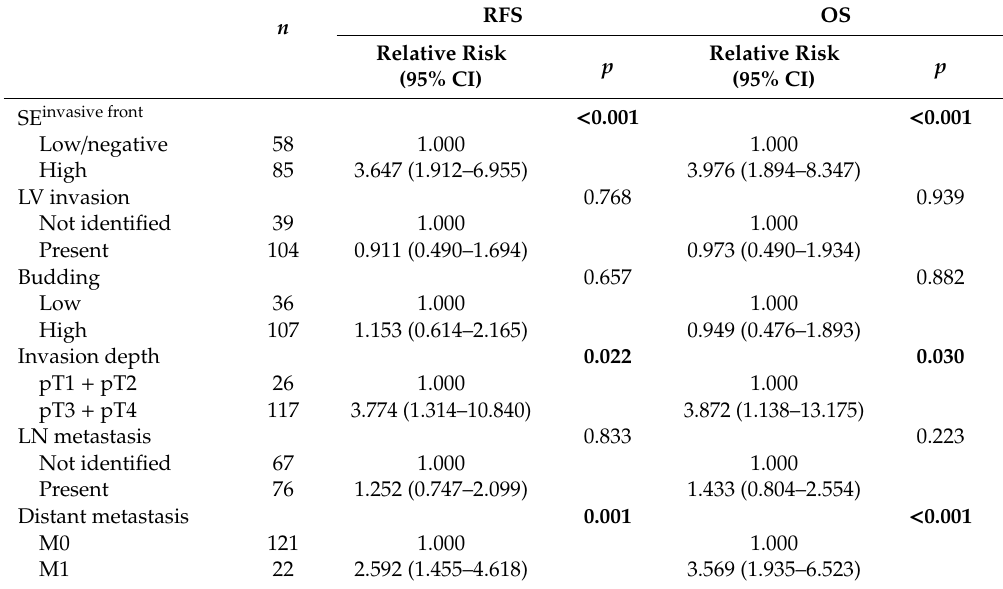
Table 3. Multivariate analysis for RFS and OS in